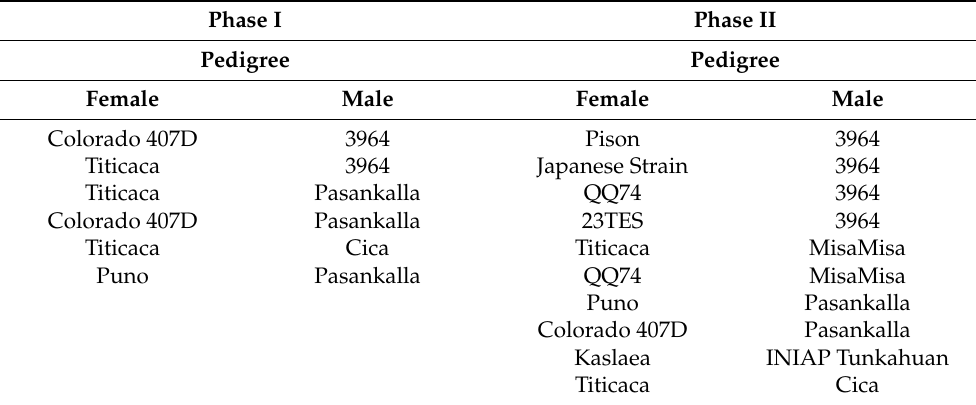
Table 6. Phase I and Phase II WSU evolutionary participatory breeding (EPB) populations grown by APROSANAMY in Cañar province, Ecuador. Phase I Phase II Pedigree Pedigree Female Male Female